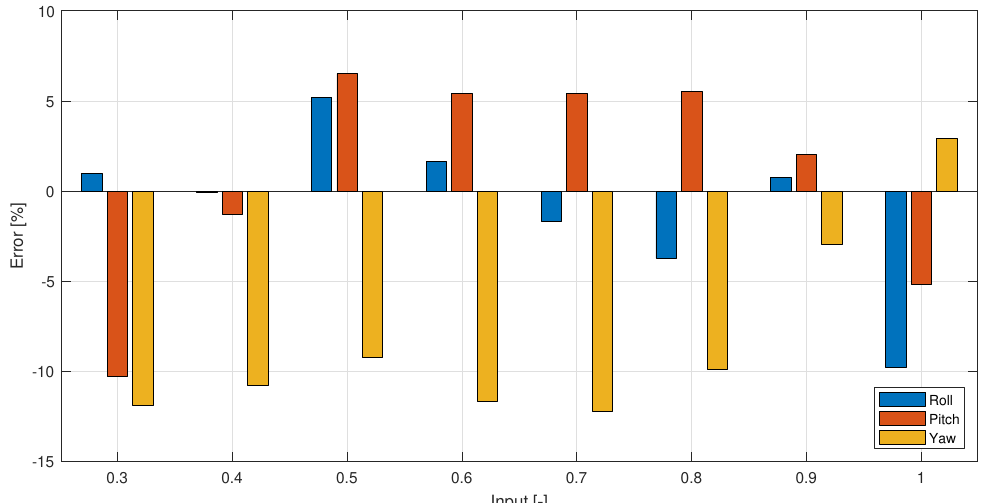
Figure 7. Model and experimental data comparison for roll, pitch, and yaw. Each of the bars represents a test similar to the one shown in Figure 5.